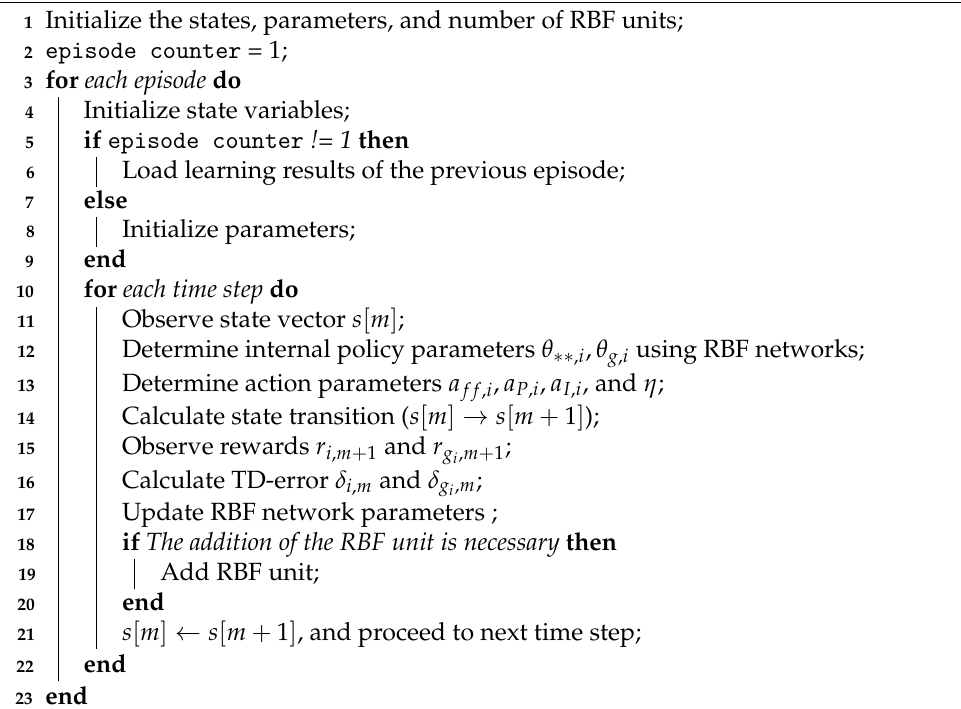
Algorithm 1 Calculation flow of the proposed two-DOF self-tuning PI